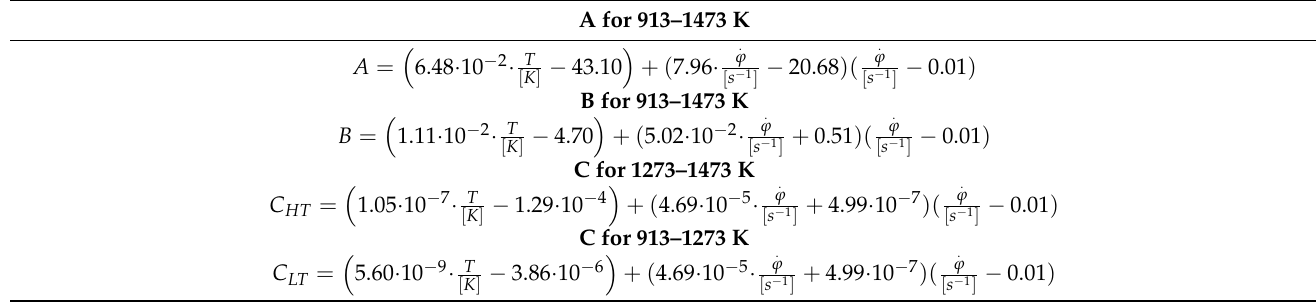
Table 3. Equations for the calculation of the ABC parameters as a function of temperature and strain . ϕ = 0.01–1 s − 1 , for the average of all investigated rate, optimized for T = 913–1473 K and